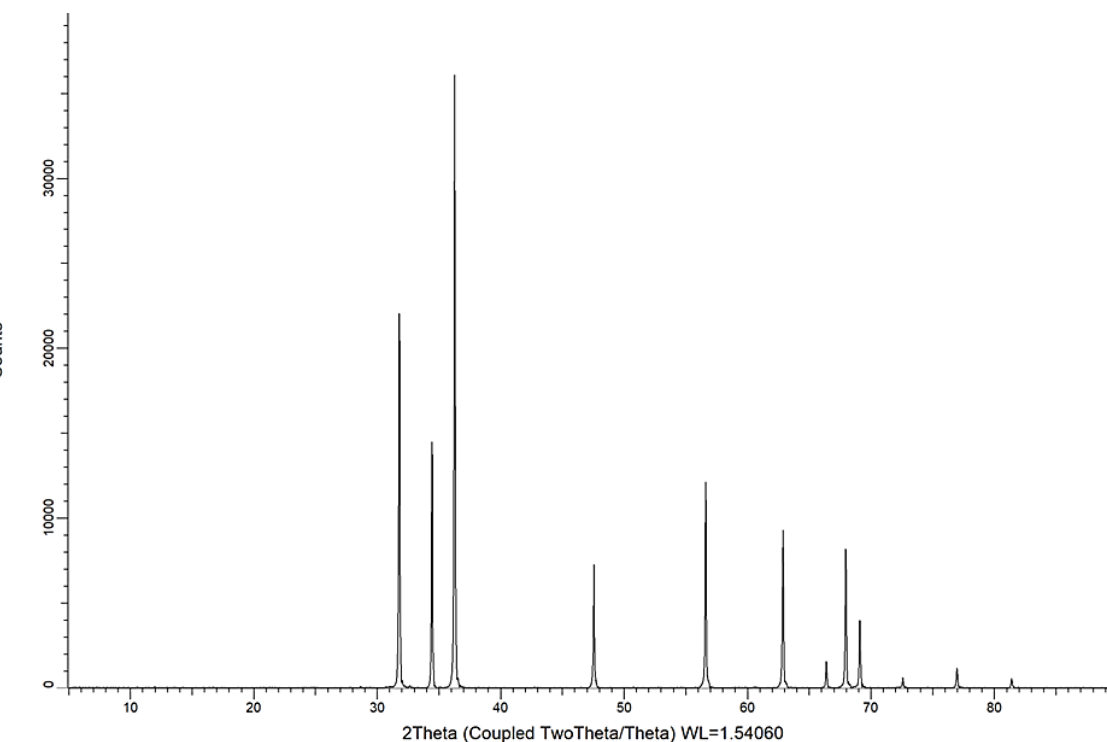
Figure 14. The XRD pattern of ZnO powder.